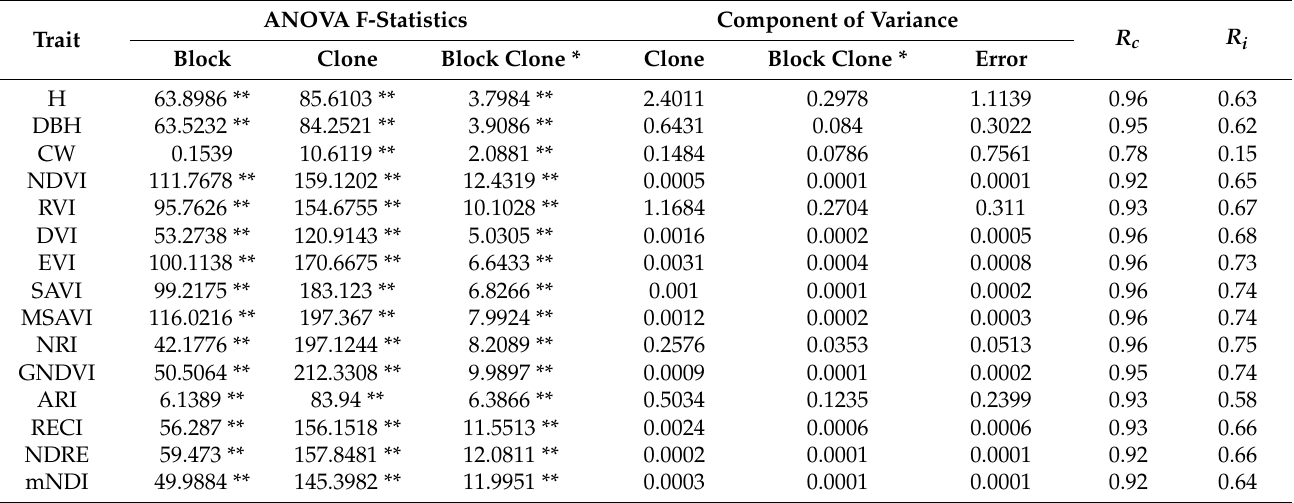
Table 4. Statistical results of linear mixed-effects models for 15 phenotypic traits at an individual tree level obtained based on DAP point clouds and multispectral